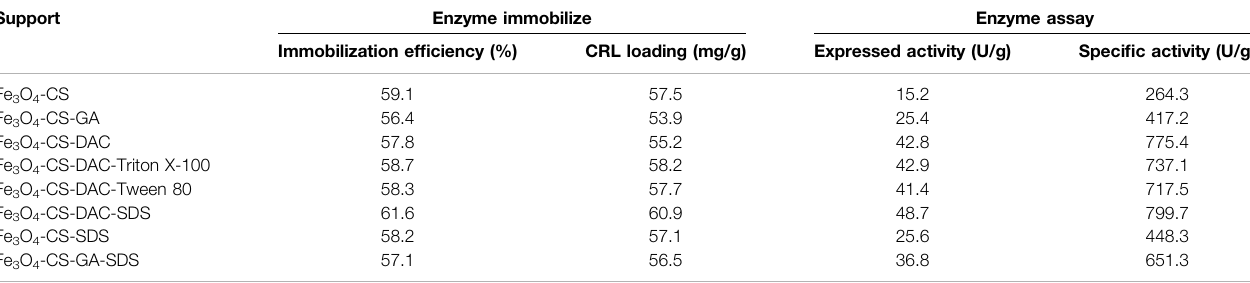
TABLE 1 | Immobilization ef fi ciency and catalytic activity of Candida rugosa lipase (CRL). Support Enzyme immobilize Enzyme